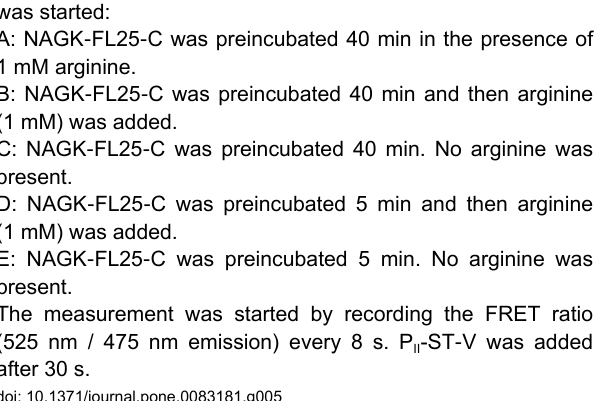
Figure 5. Influence of arginine and NAGK preincubation on P - NAGK complex formation. Before the measurement II was